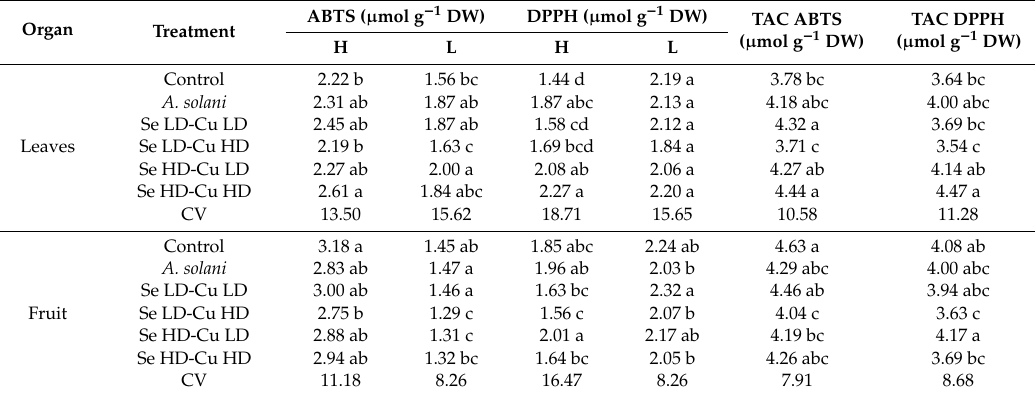
Table 5. Total antioxidant capacity of tomato leaves and